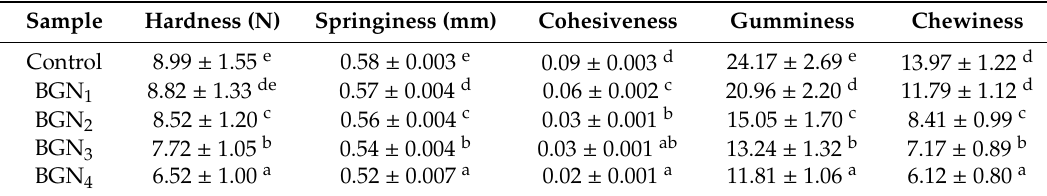
Table 4. Textural profile analysis of tortillas added with Bambara groundnut